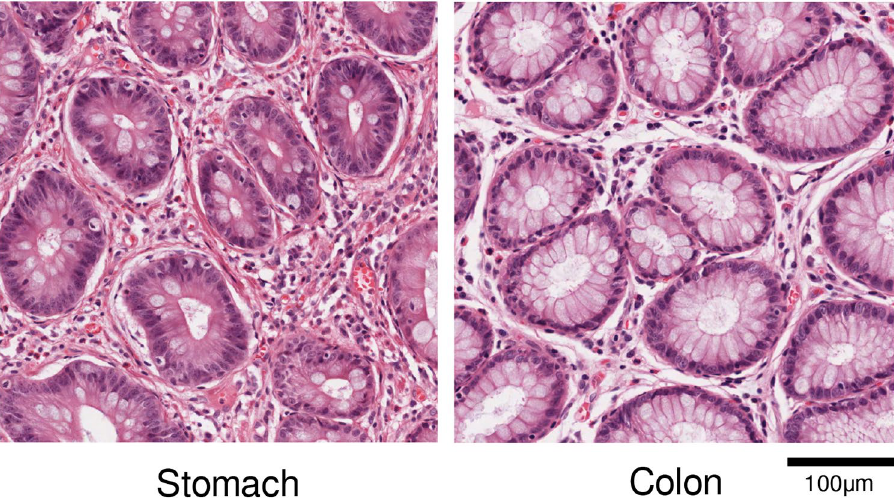
Figure 1. Examples of H&E slide patch from gastric and colonic tissues. On the left are gastric glands with intestinal metaplasia, and on the right are colonic glands. The two tissues share similar histological